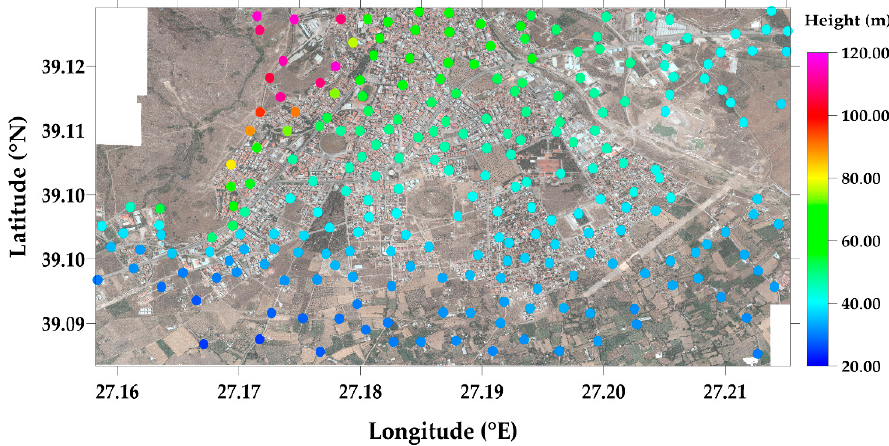
Figure 7. Manually selected Geoid control points scattered on the study area. Color bar shows the orthometric heights of the points in meters.